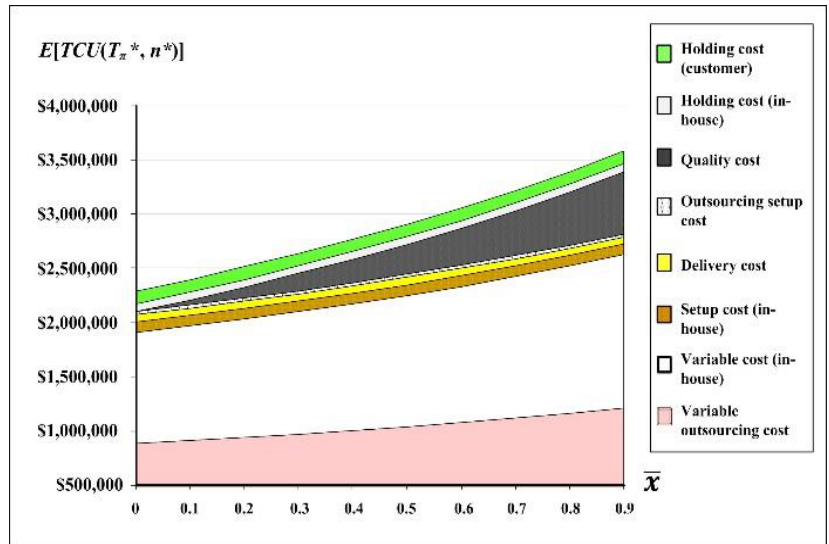
Figure 7. Impact of variations in x on system’s cost